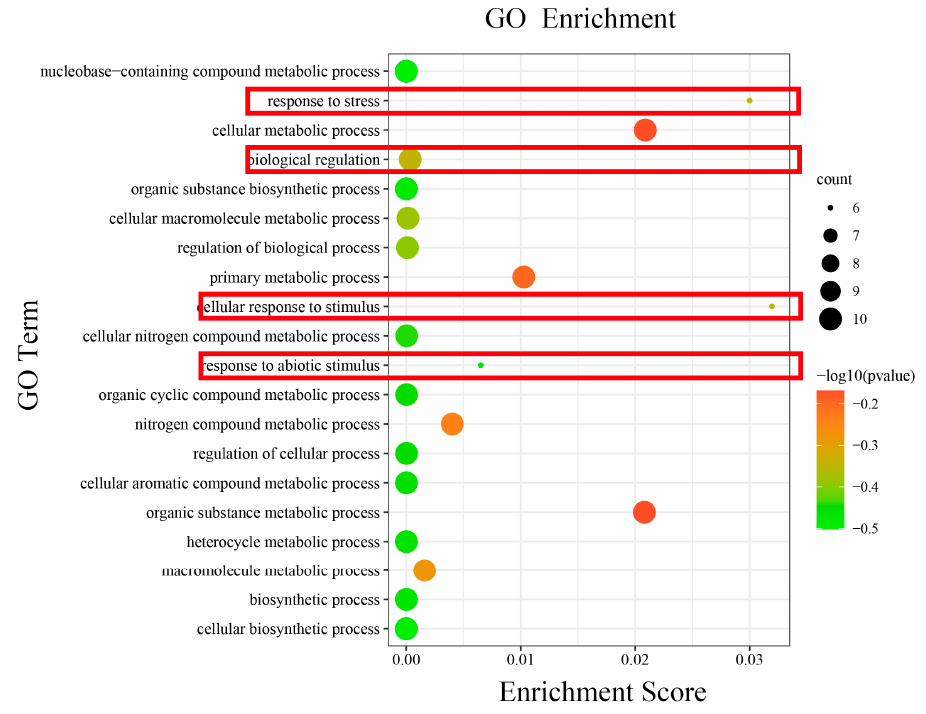
Figure 6. The GO terms enriched of HmCAMTA genes. The black circles indicate the number of target genes and different colors indicate the p -value. The red boxes represent functions related to drought stress.